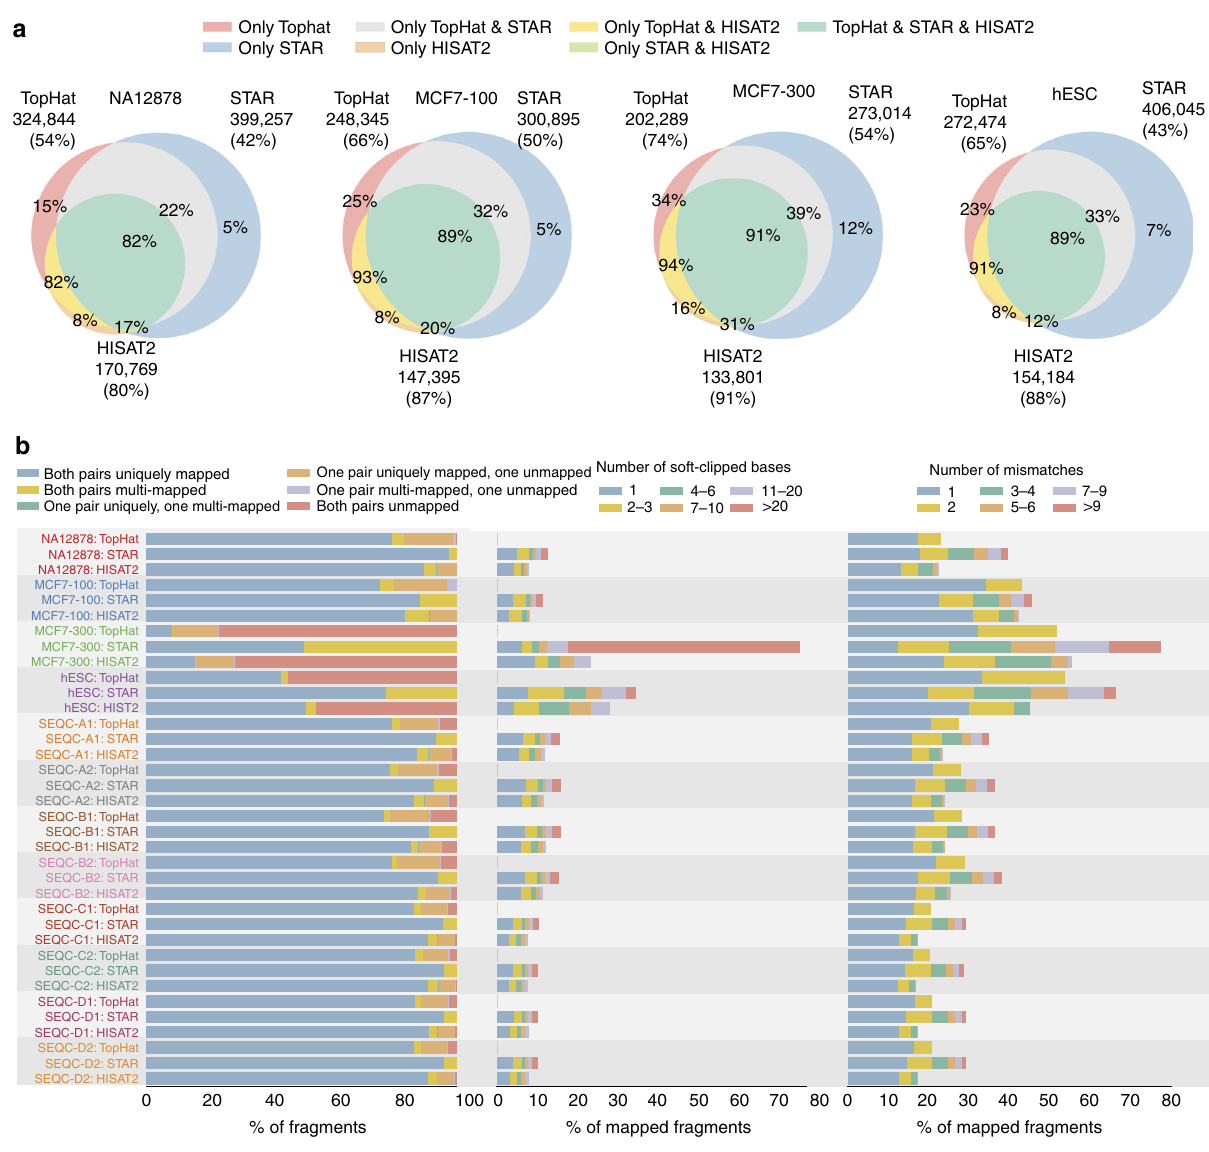
Fig. 2 Performance of different alignment schemes. a Overlap between the detected splice junctions by different schemes and their validation rate on reliable junctions in dbEST database 74 . A reliable EST junction set consists of junctions supported by at least two ESTs. The sizes of the circles re fl ect the number of junctions called by each scheme. For each tool, the number of junctions called and the validation rates (in parentheses) are shown. Validation rates for each subset of junctions are also shown on the Venn diagram. b Read mapping analysis: distribution of mapping status of sequenced fragments ( left ) (for NA12878, MCF7, and SEQC samples, mapping status for paired-end reads are shown, while for hESC, the distribution re fl ects percentage of uniquely mapped ( blue ), multi-mapped ( orange ), and unmapped ( red ) single-end reads), distribution of number of soft-clipped bases in mapped fragments ( middle ), distribution of the number of mismatches in mapped fragments ( right